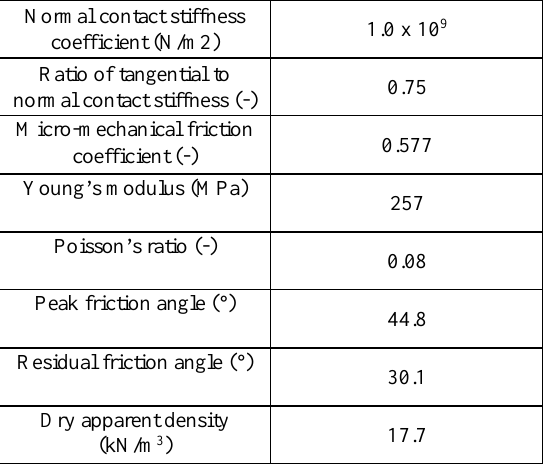
Table 1. Micro and macro mechanical parameters of the granular layer discrete